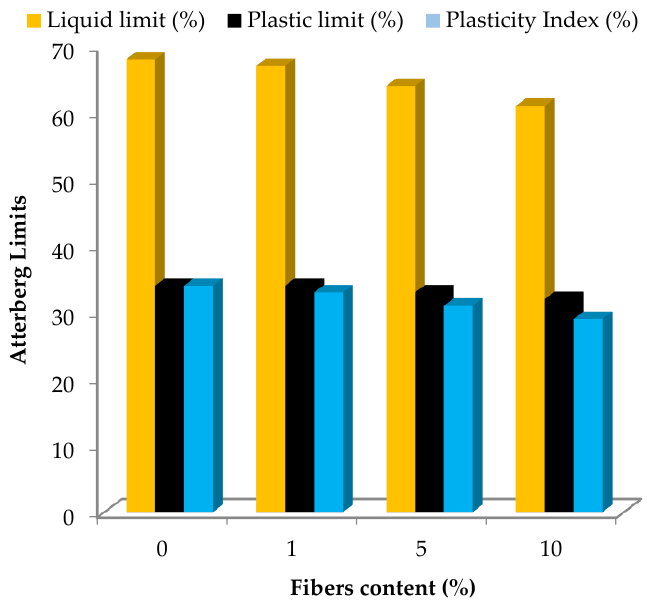
Figure 8. Variation of the Atterberg limits according to the Diss fibers ’ content.